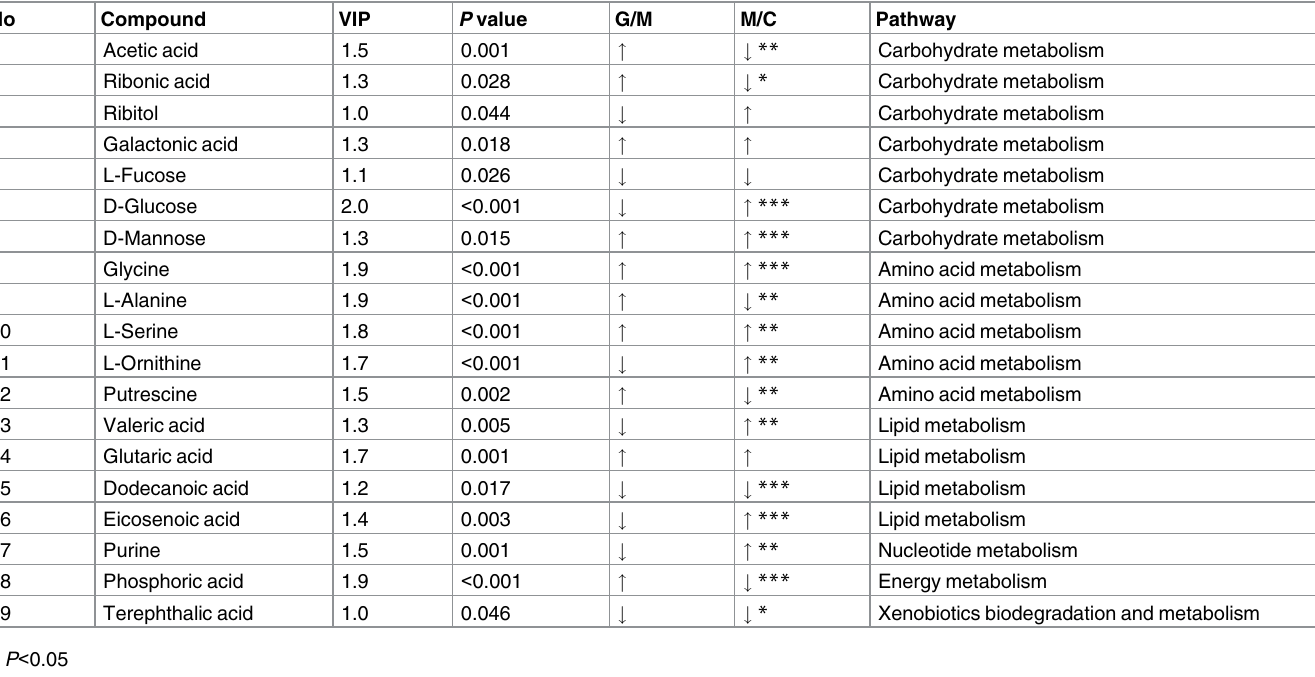
Table 2. Significantly altered metabolites and their